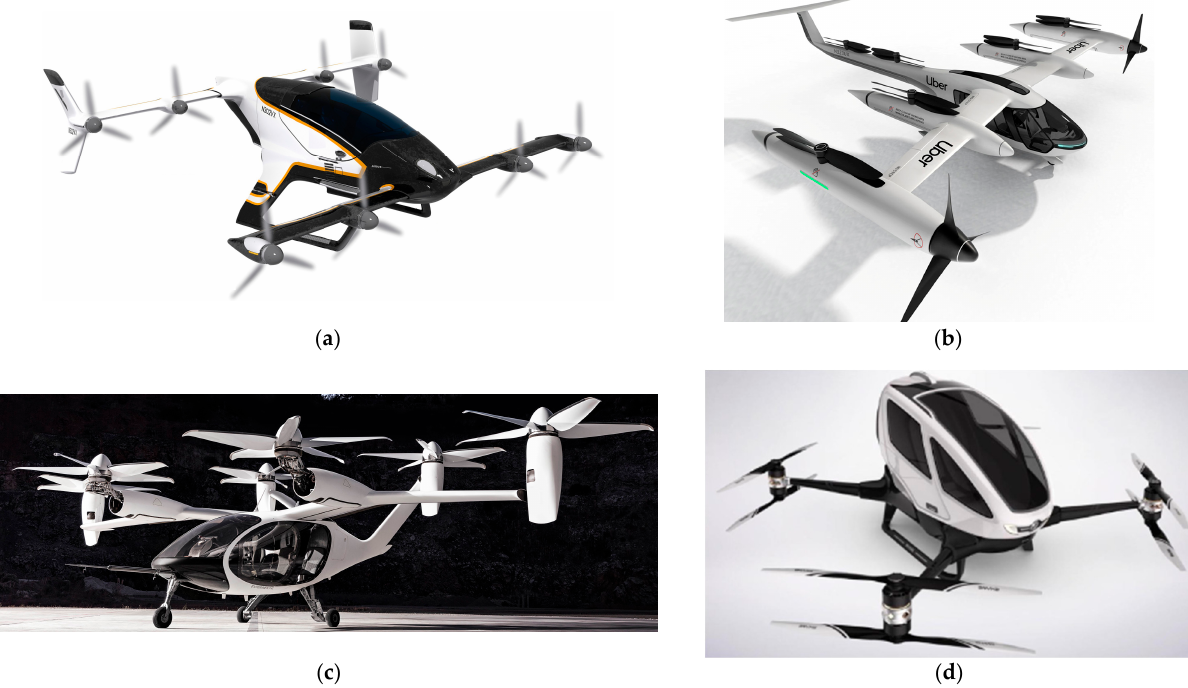
Figure 1. Different e-VTOL configurations developed from 2016: ( a ) Tilt-Wing (T-W) [25]; ( b ) Lift+Cruise (L+C) [26]; ( c ) Tilt-Rotor (T-R) [27]; ( d ) Multi-Rotor (M-R) [28].